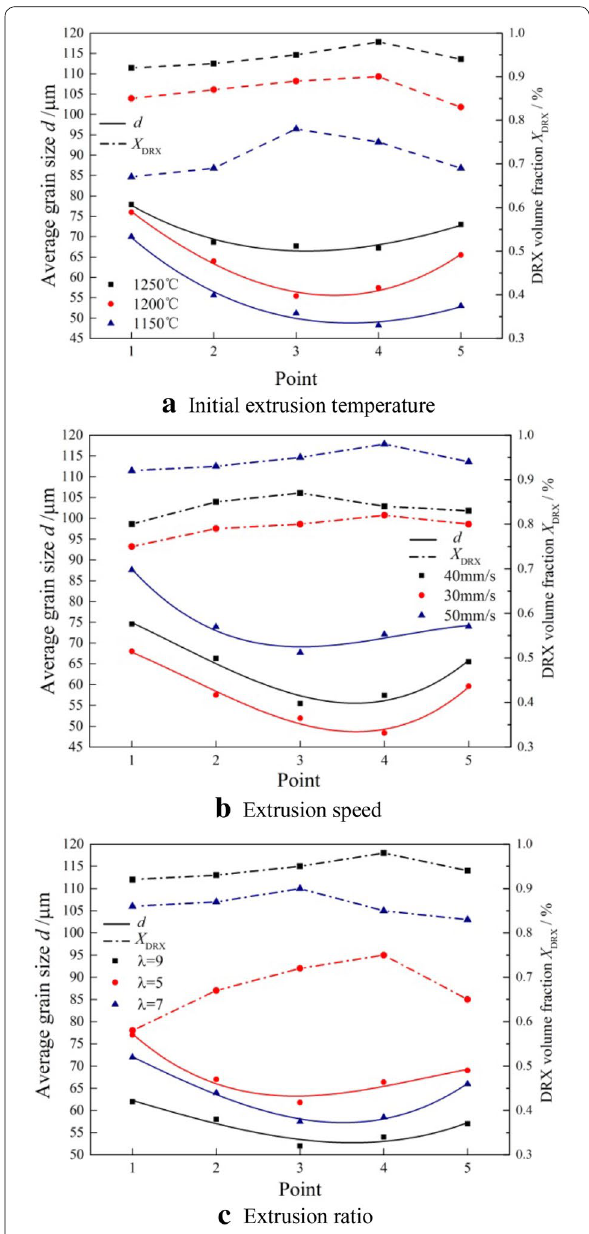
Figure 13 Effects of extrusion parameters on grain sizes and DRX volume fractions in stable